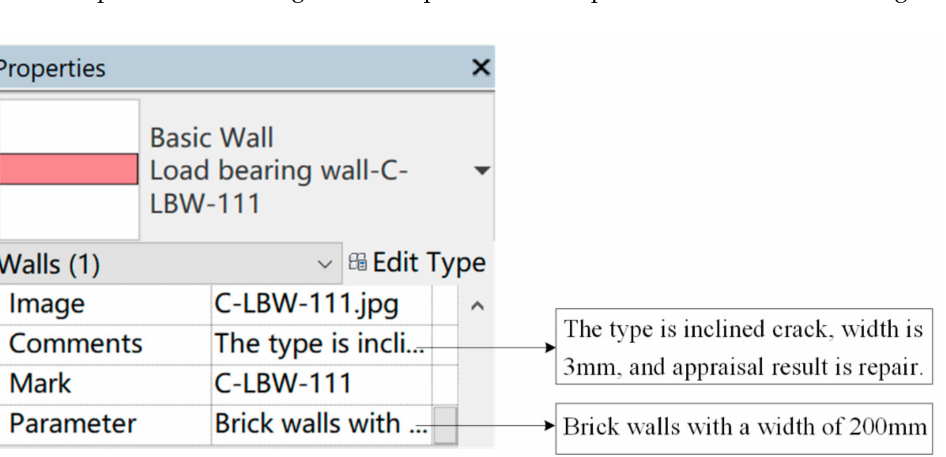
Figure 4. Information integration